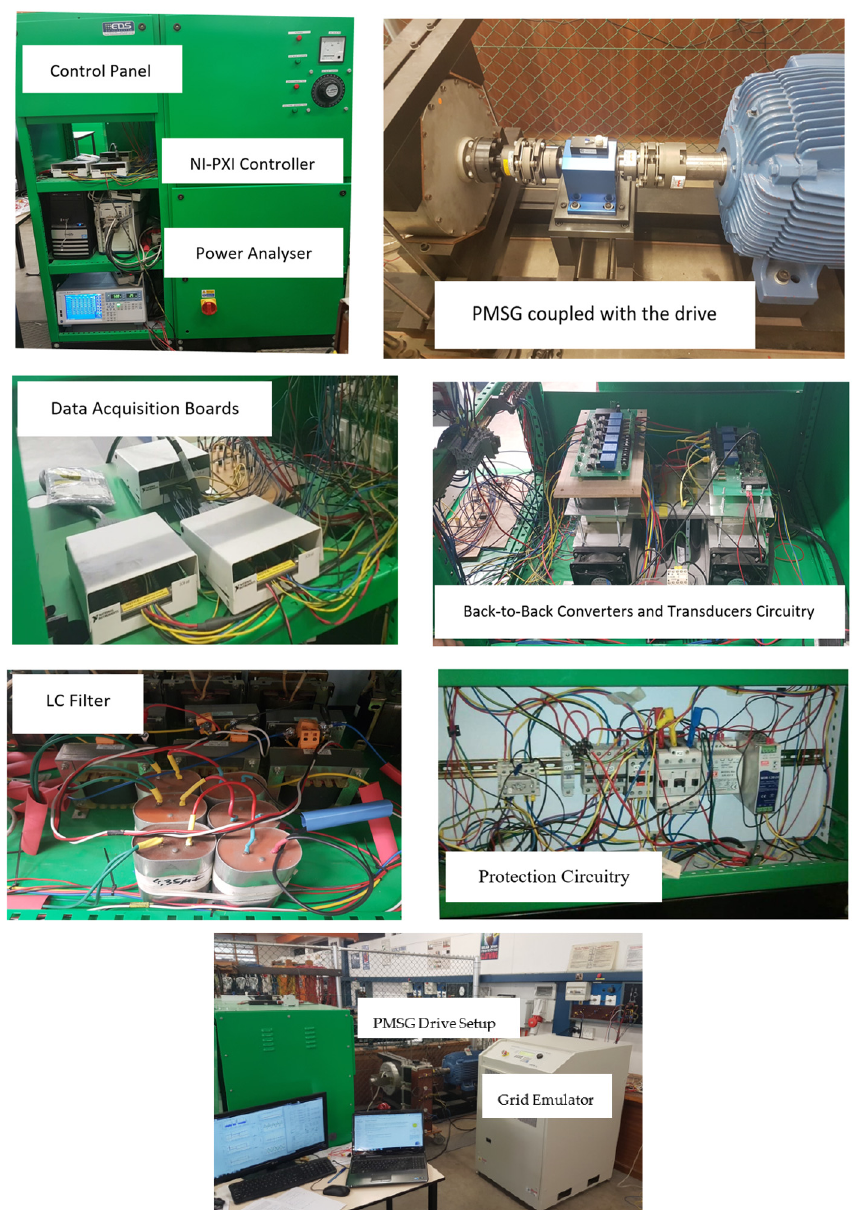
Figure 11. Experimental setup: control panel, grid emulator, PMSG, and its drive.